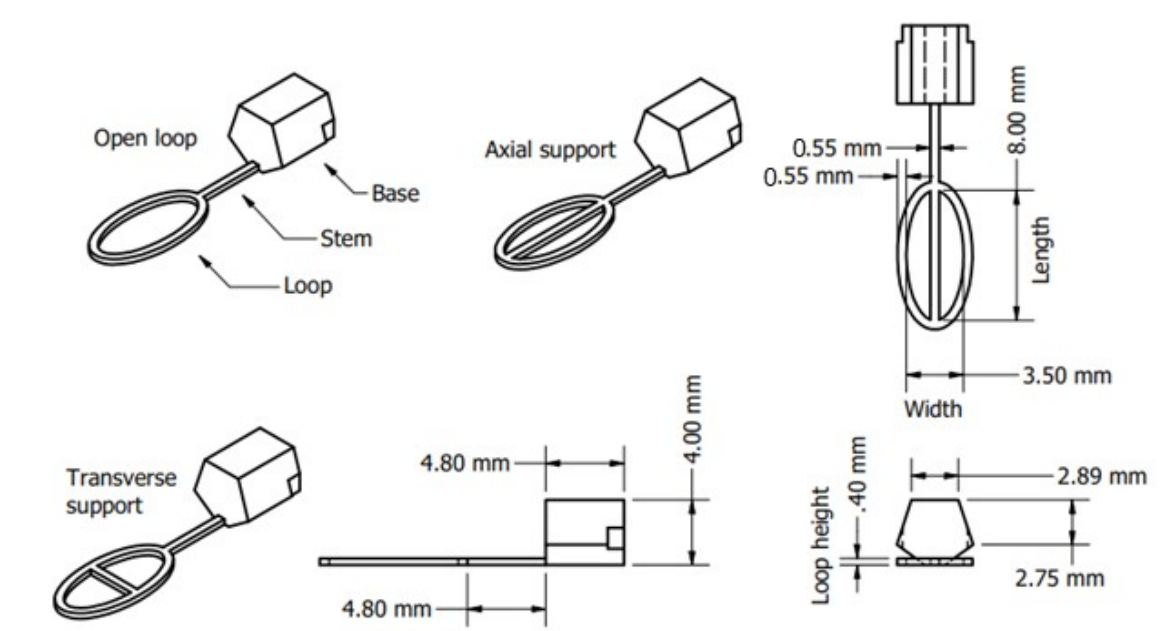
Figure 2. Dimensioned drawings of the 8-mm axial support VDCV. A total of 36 configurations were developed and tested, including three different support configurations (open, axial, and transverse); 3 different loop lengths (8, 10, and 12 mm); and four different loop widths (2, 2.5, 3, and 3.5 mm).